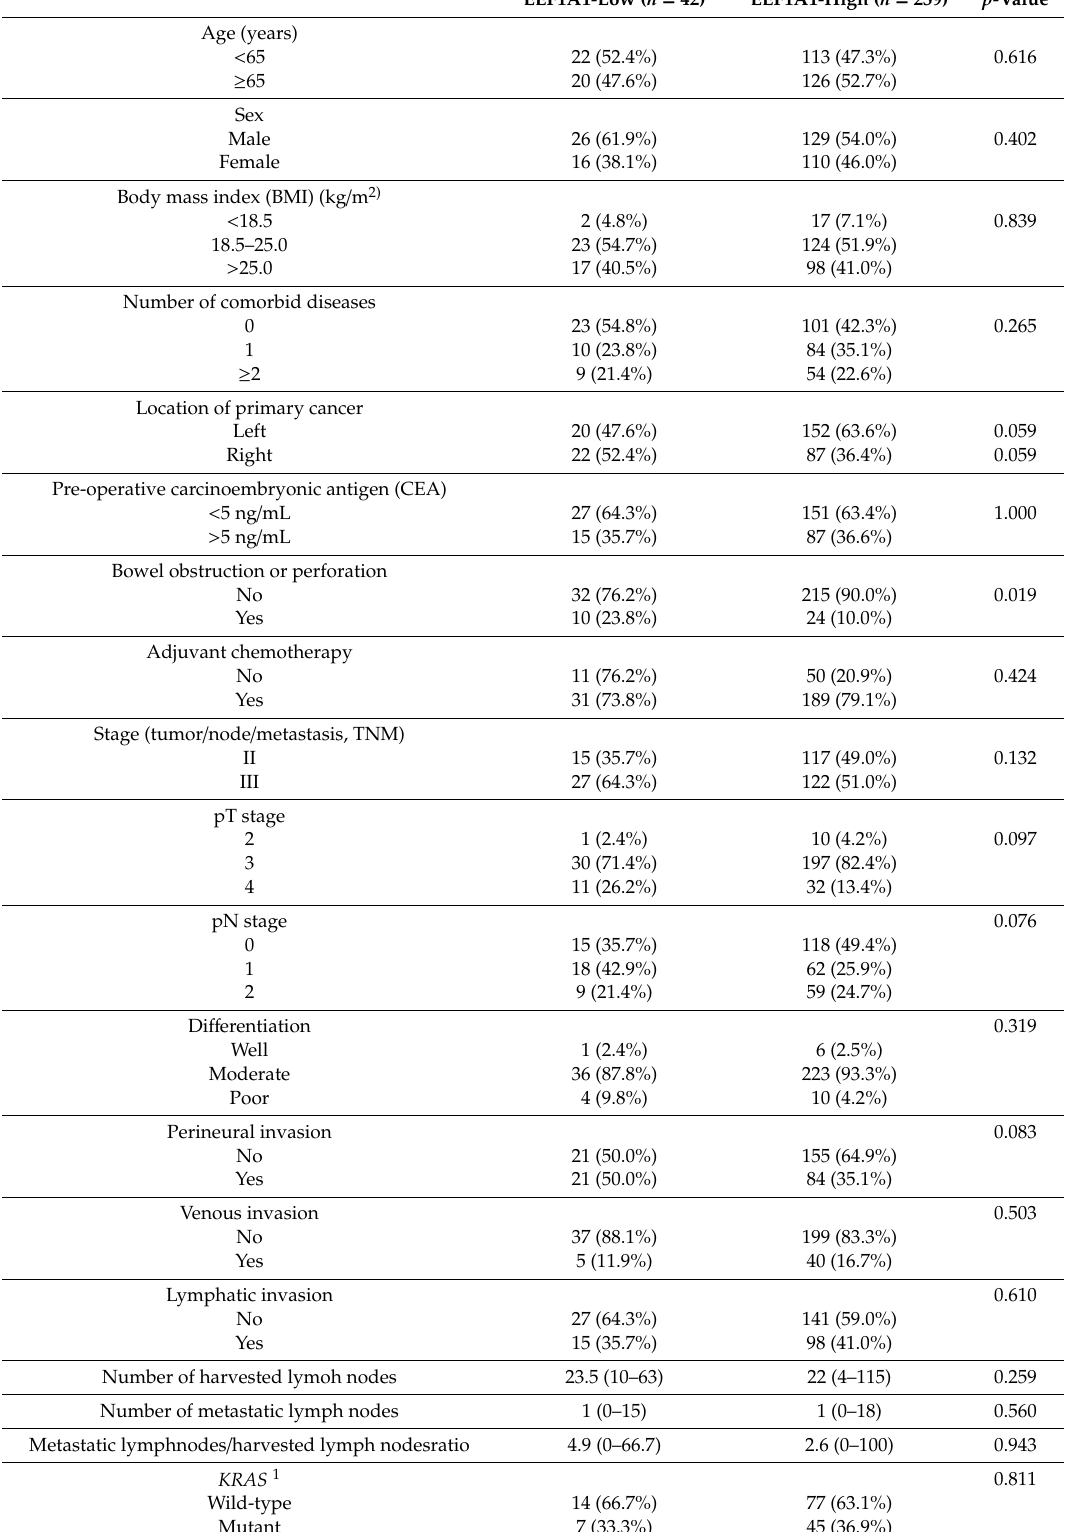
Table 1. Baseline characteristics of colon cancer patients stratified based on EEF1A1